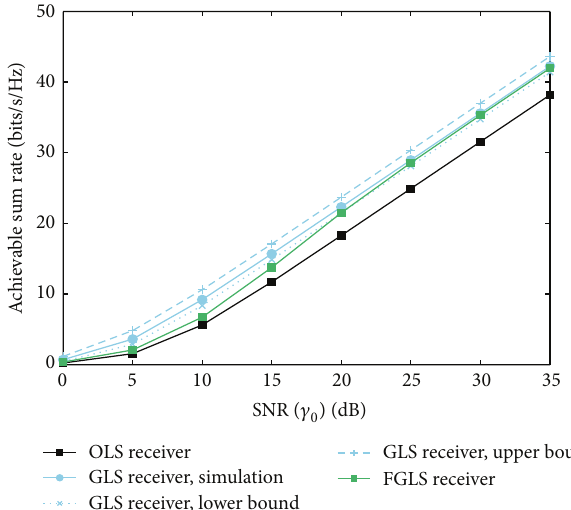
Figure 1: Sum rate of OLS, GLS (simulated and bounds), and FGLS